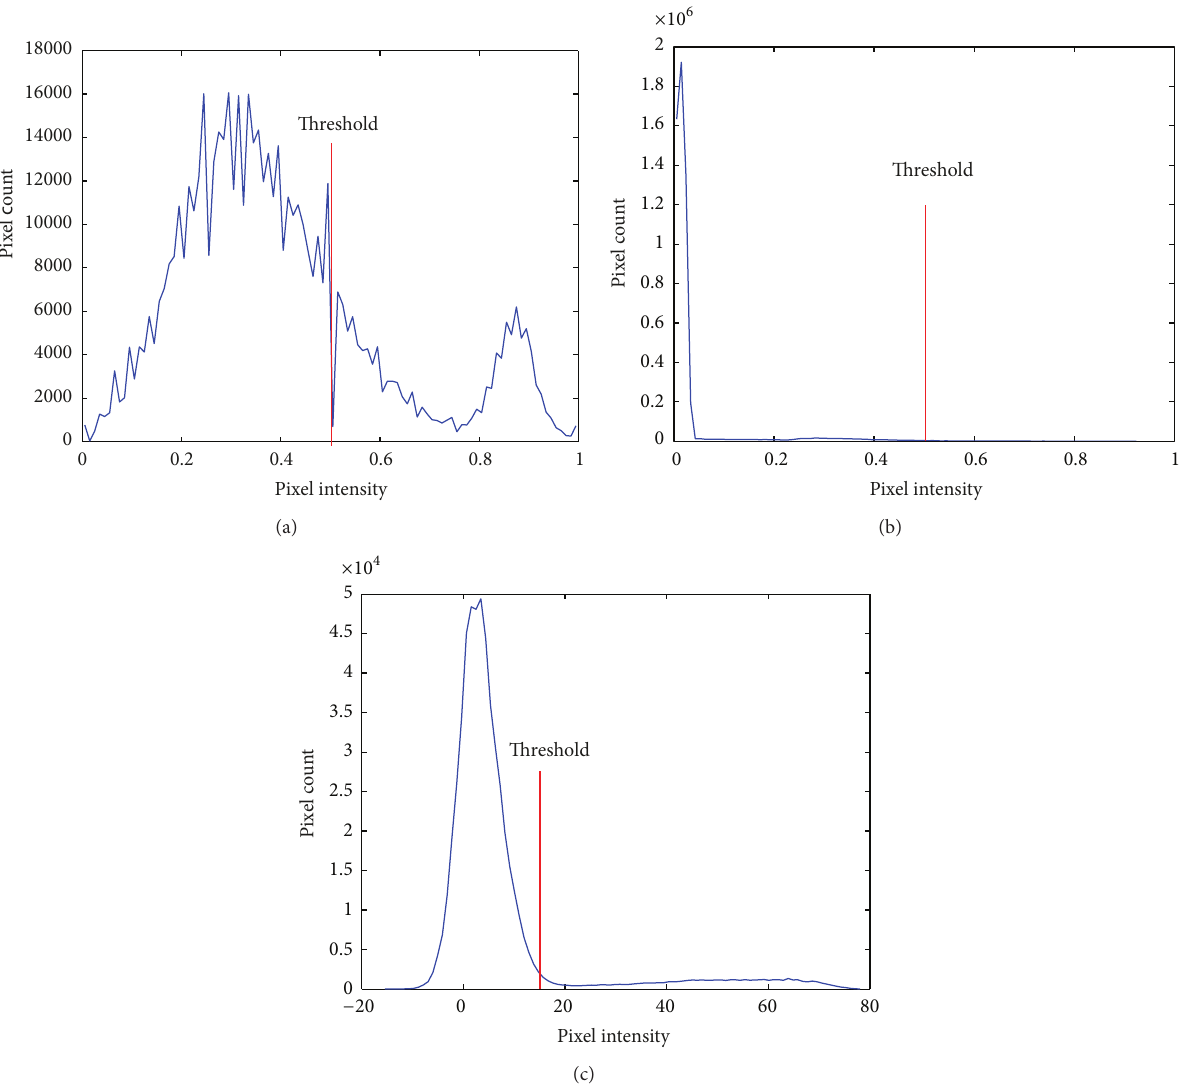
Figure 7: Histogram of the (a) “ 𝑆 ” component of HSV color spaces, (b) “ 𝑌 ” component of CIE 𝑋𝑌𝑍 color space, and (c) “ 𝑎 ” component of CIE 𝐿 ∗ 𝑎 ∗ 𝑏 ∗ color spaces.